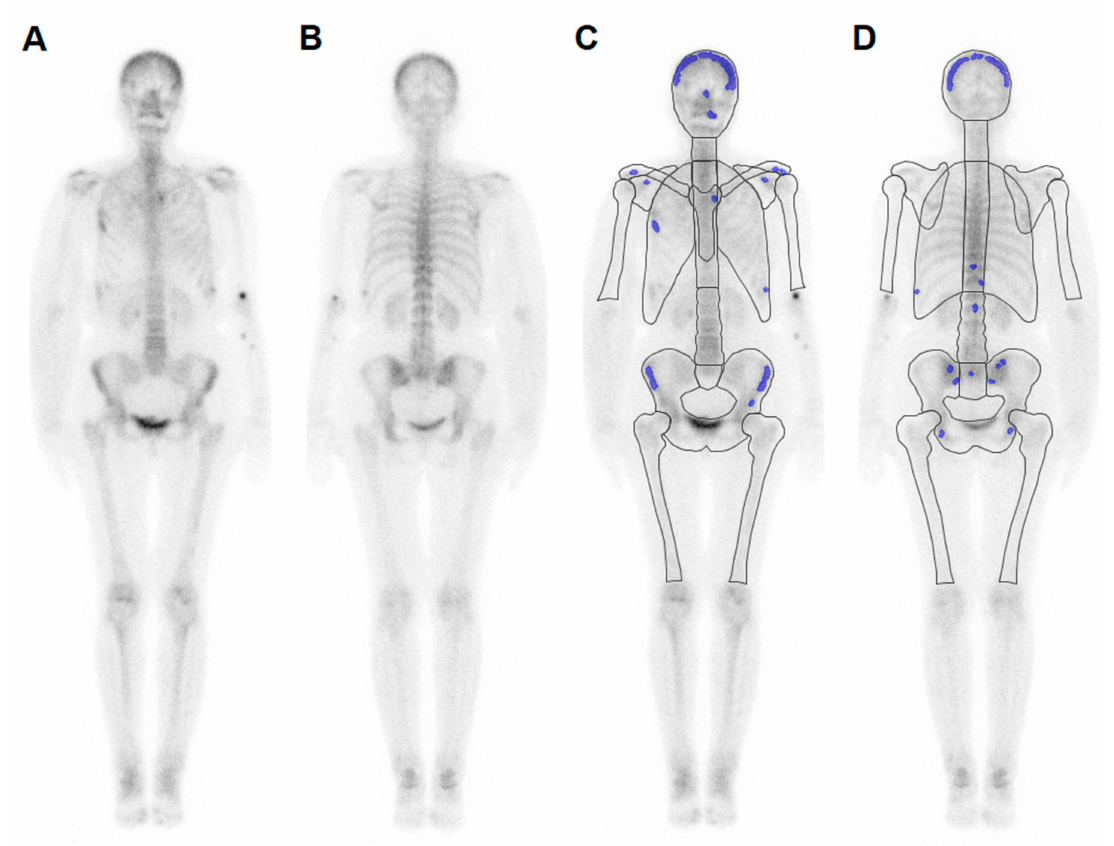
Figure 2. ( A , B ) Bone scan of a female patient with breast cancer and ( C , D ) results from atlas-based segmentation. Pathologic lesions were automatically segmented (labeled in blue) and correctly rated to be benign (BSI = 0.0%); ( A , C : anterior projection; B , D : posterior